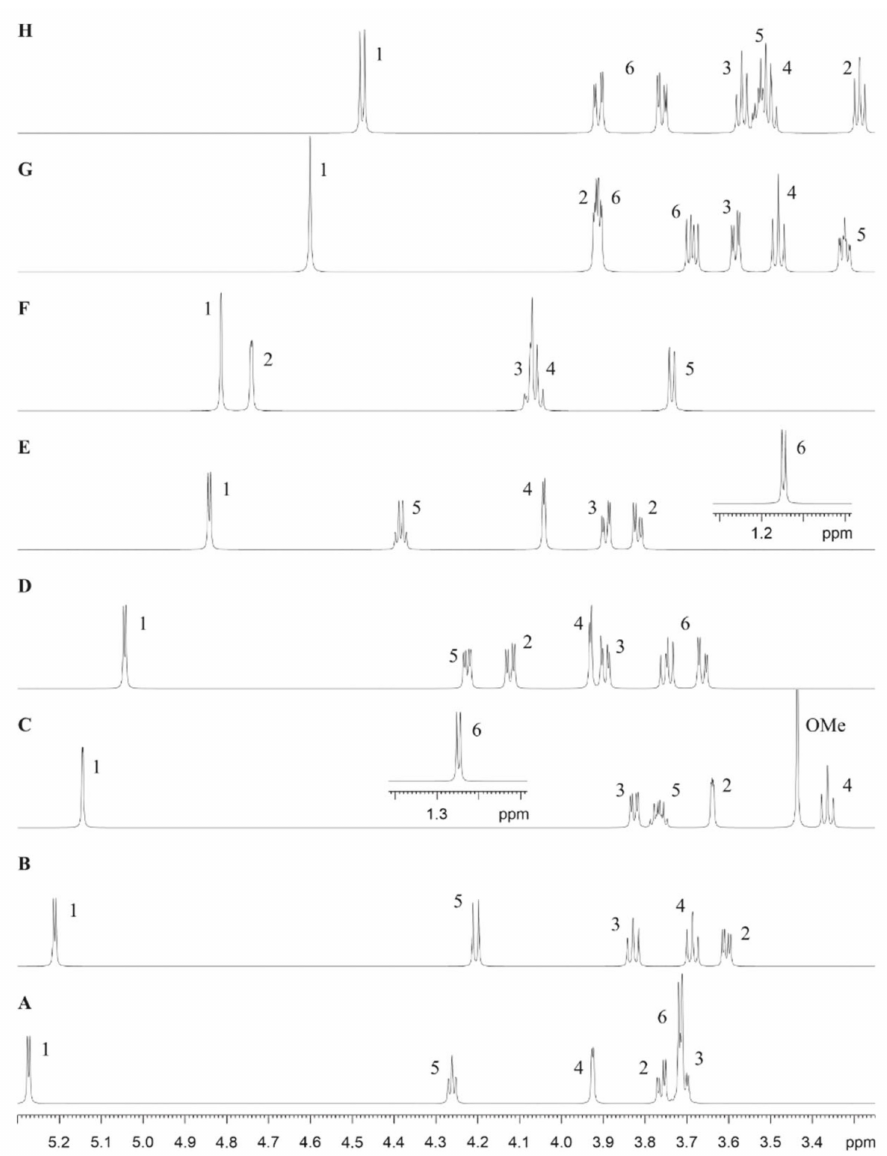
Figure 2. Simulated 1 H NMR spectra of the sugar units ( A – H ) of the B. fragilis wild-type O -glycan released from gly- copeptides. The traces A – H show the individual spin systems together with the assignment of the sugar protons. OMe,